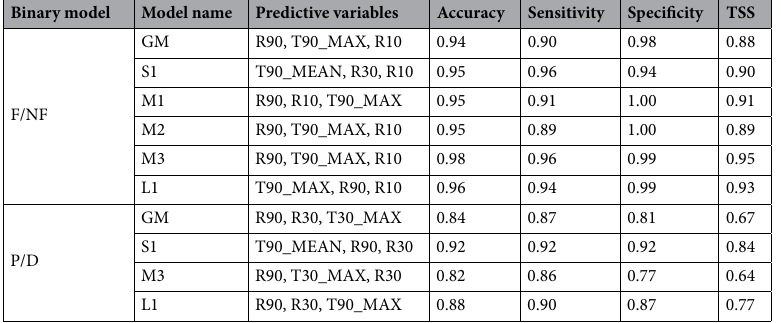
Table 4. Predictive variables and performances obtained for the oversampled RF models. Models variables are listed in terms of descending importance for classification result (from left to right). Binary models code: F/NF = non-flowing/flowing, P/D = dry/ponding. Predictive variables code: R90 = cumulative 90-days rainfall, R30 = cumulative 30-days rainfall, R10 = cumulative 10-days rainfall, T90_MAX = average of previous